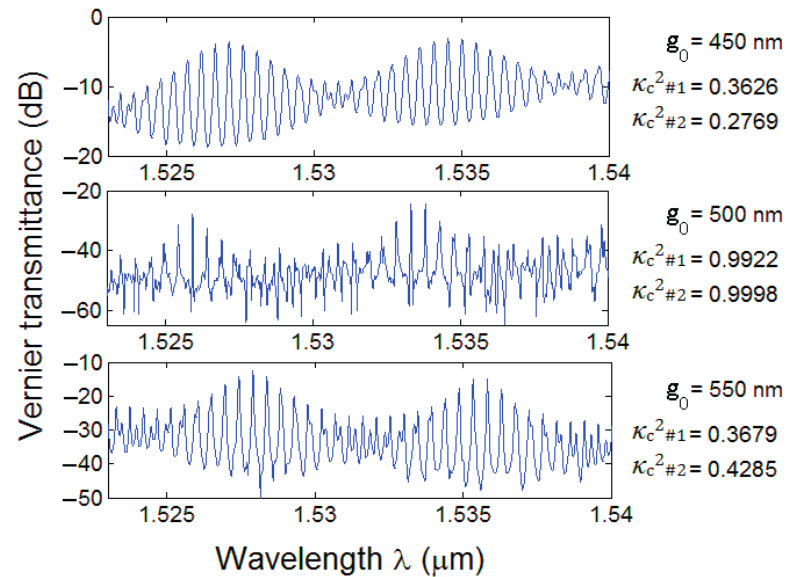
Figure 10. Normalized transmittances of Vernier D architecture as a function of different directional coupler gap values with estimated power coupling coefficients.